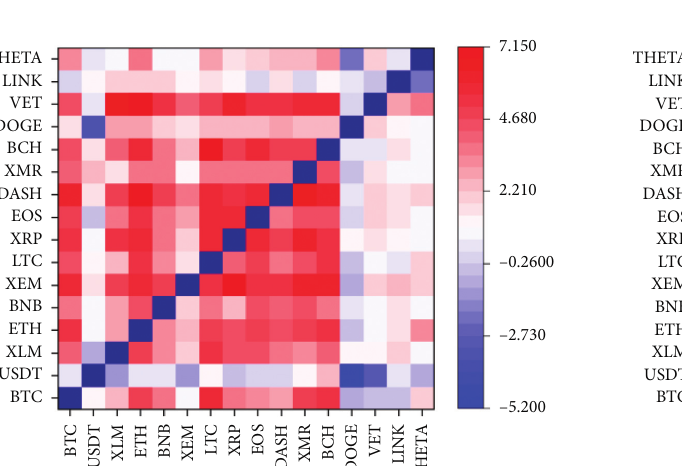
Figure 6: Causality test under